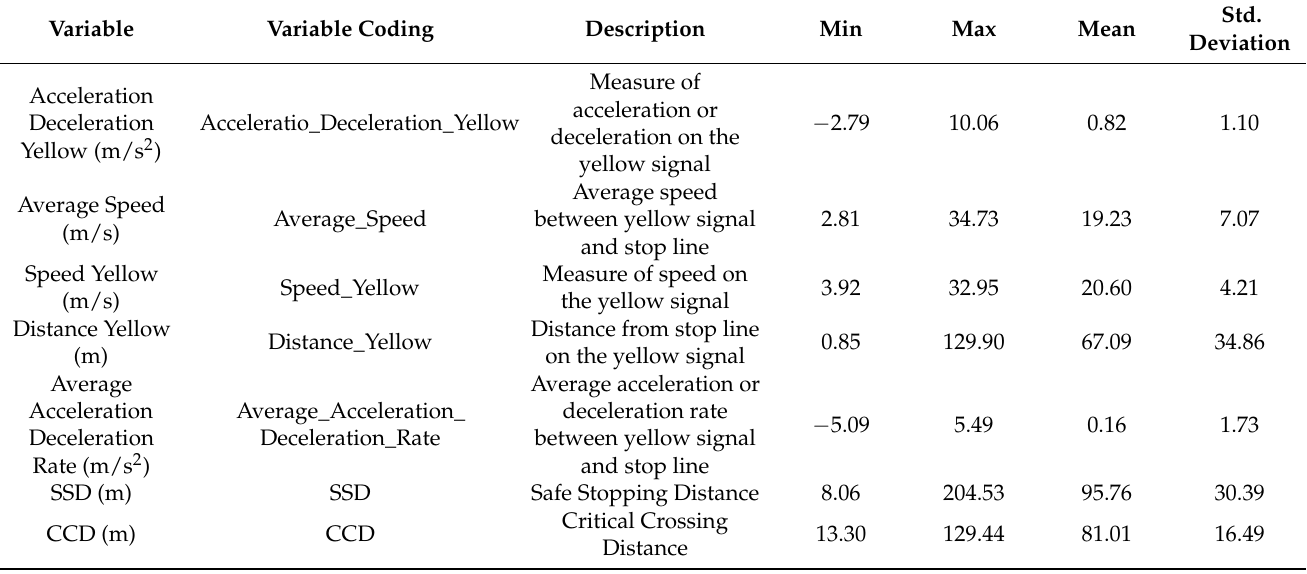
Table A1. Descriptive statistics of main scale